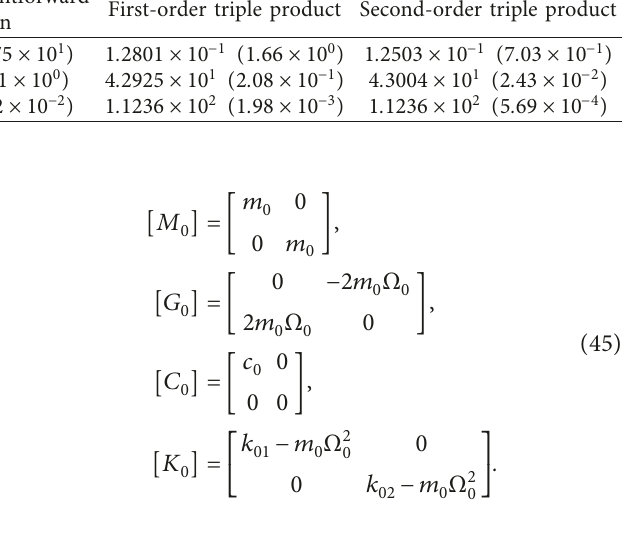
Table 1: The exact and approximate natural frequencies for the perturbed torque-free rigid body of Figure 1 for σ First-order straightforward Second-order straightforward First-order triple product Second-order triple product Exact perturbation perturbation